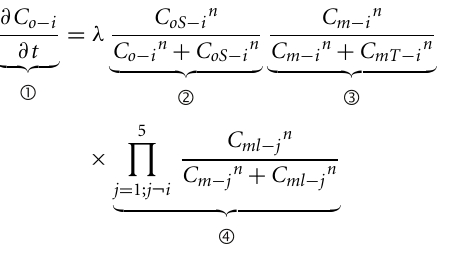
FIGURE 5 | Lateral view of a 3D domain .The relative distance from inferior surface of the domain ( x rel ) and reference position ( x ref ) are indicated. Our model limits differentiation to those cells below the reference position.